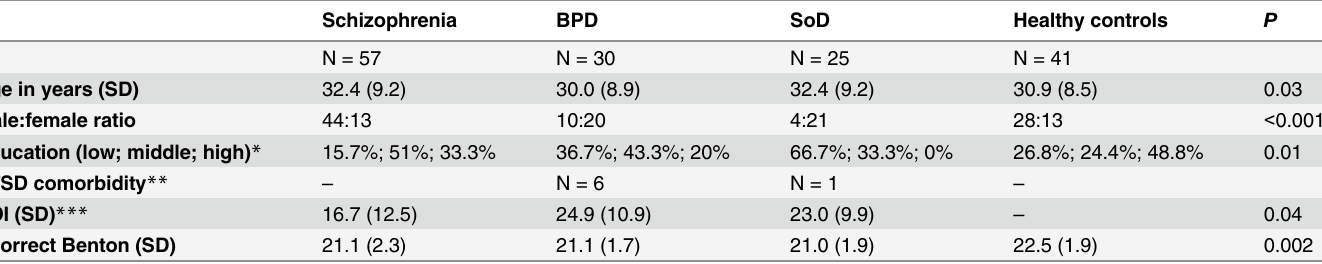
Table 1. Age, sex, and general face recognition performance for each of the four groups. P values are derived from overall group ANOVA highlighting significant differences across all